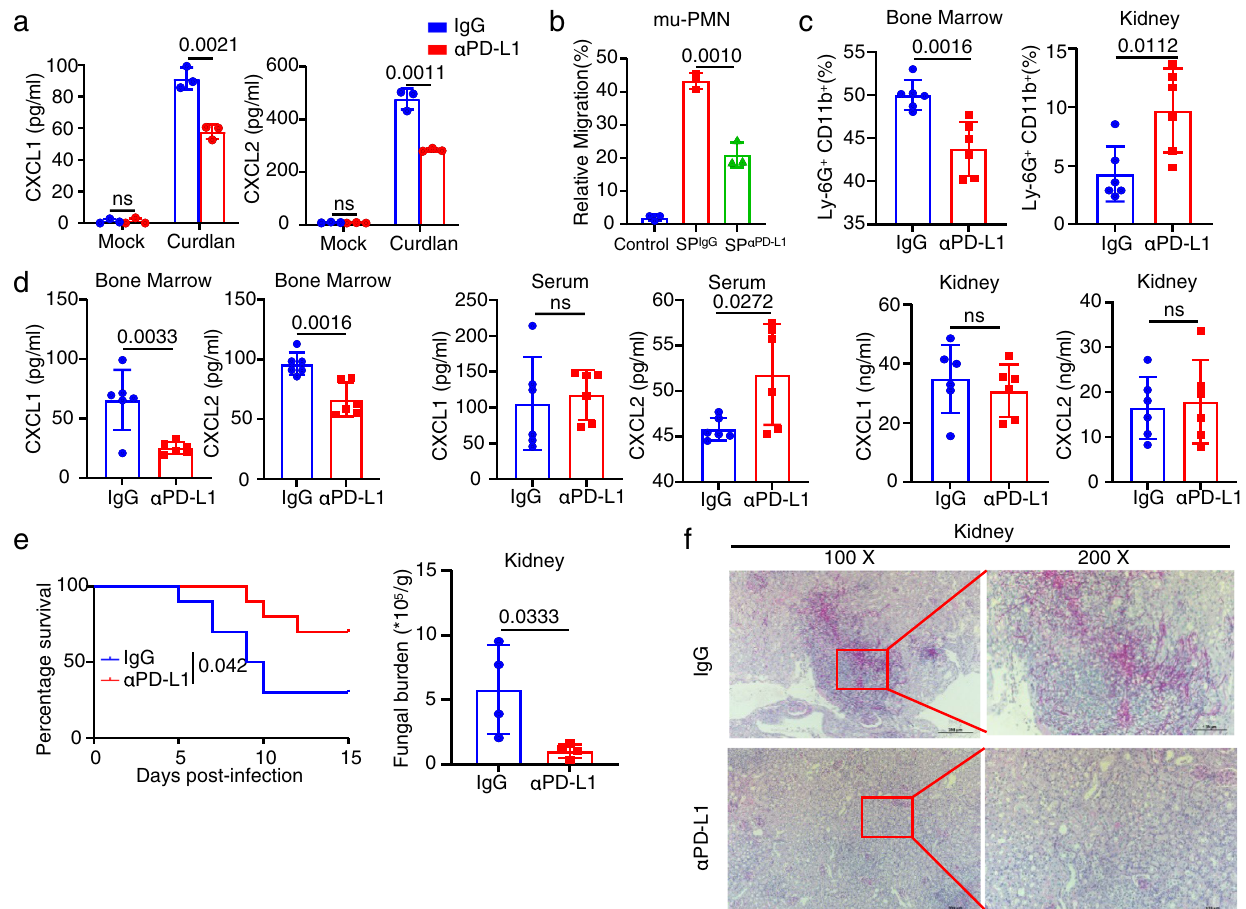
Fig. 6 | PD-L1 blockade facilitates neutrophil-based immunotherapy against lethal C. albicans sepsis. a ELISA quanti fi cation of CXCL1 and CXCL2 in the supernatant of wild-type mu-PMNs treated with anti-PD-L1 ( α PD-L1, 10 μ g/ml), which were co-stimulated with curdlan (25 μ g/well) for 4h. b Trans-well migration assay of naive neutrophils driven by the supernatants of wild-type mu-PMNs sti- mulated with curdlan (25 μ g/well) combined with anti-PD-L1 ( α PD-L1, 10 μ g/ml) or IgG treatment for 4h. c – f The percentage of neutrophils in bone marrow and kidney ( c ), ELISA quanti fi cation of CXCL1 and CXCL2 in bone marrow, serum and